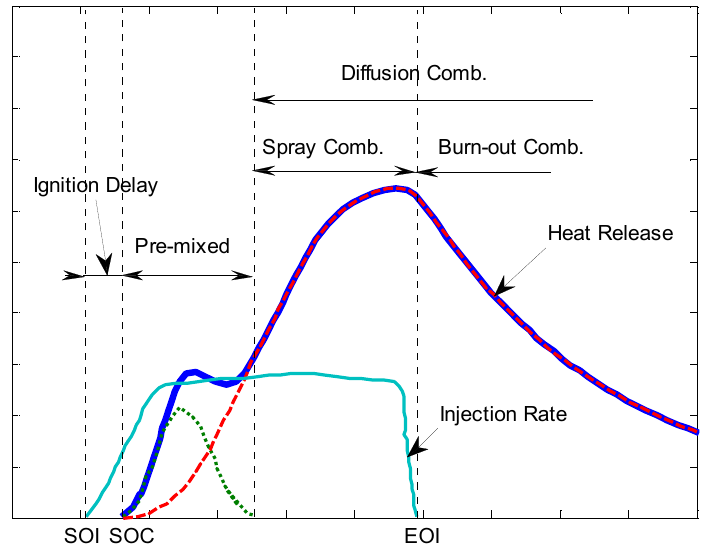
Figure 4. Phases of combustion in a diesel engine.